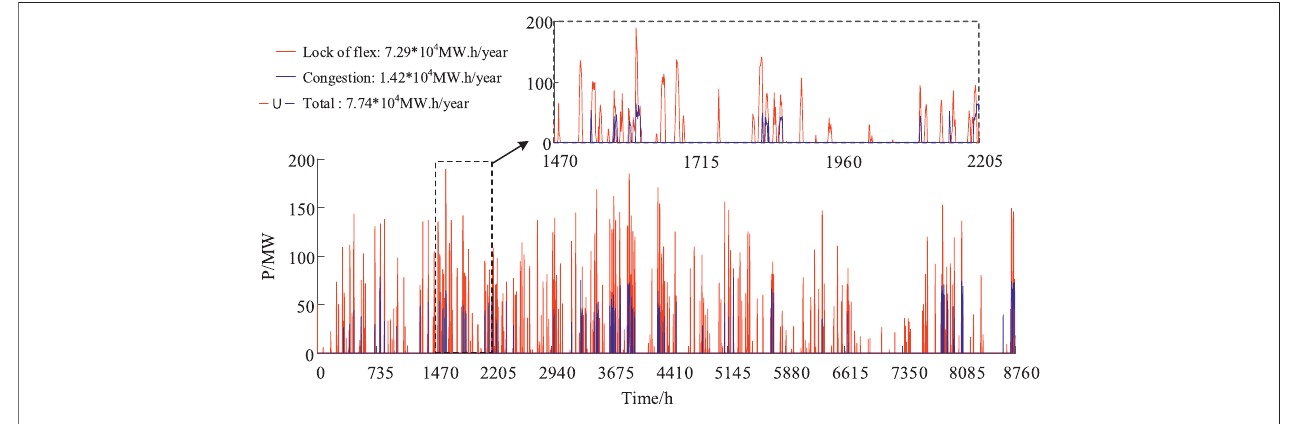
FIGURE 11 | Coupling relationship of wind curtailment in Garver6